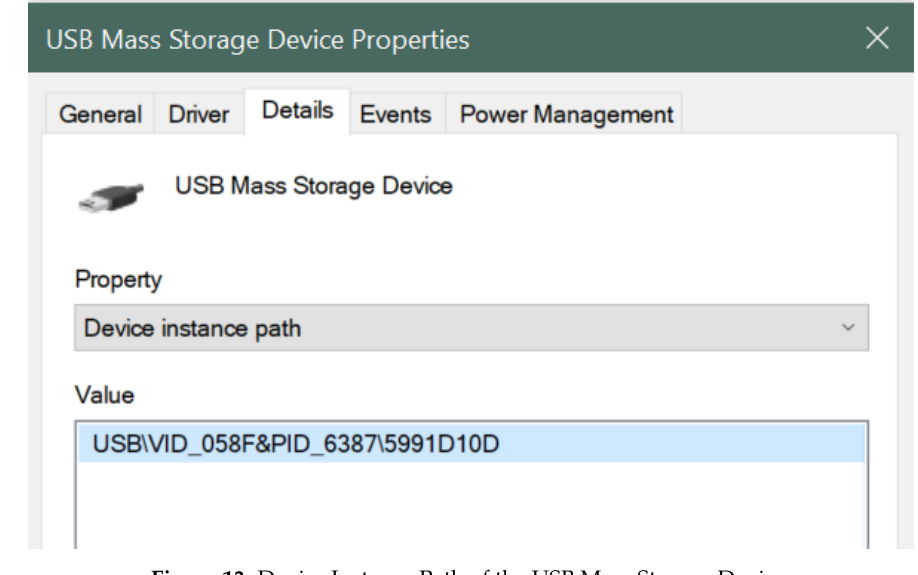
Figure 13. Device Instance Path of the USB Mass Storage